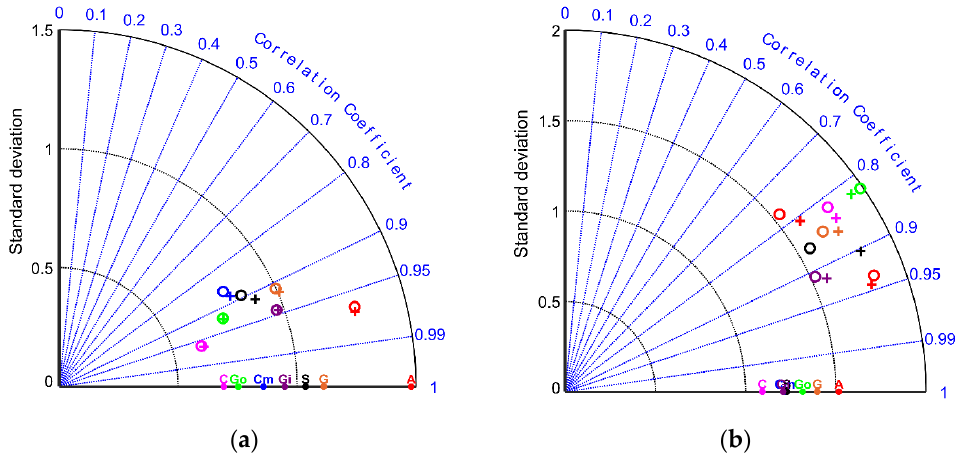
Figure 6. Taylor diagram for the case studies in Table 3. Results for Hs ( a ) and Tm ( b ) are reported. The plus symbols (+) and circle ( ◯ ) symbols refer to time steps equal to 60 and 120 s, respectively. Each buoy is represented by a different color: Alghero (A) in red, Capo Mele (Cm) in blue, Castiglione (C) in pink, Giannutri (Gi) in purple, Gombo (Go) in green, Gorgona (G) in orange and La Spezia (S) in black.